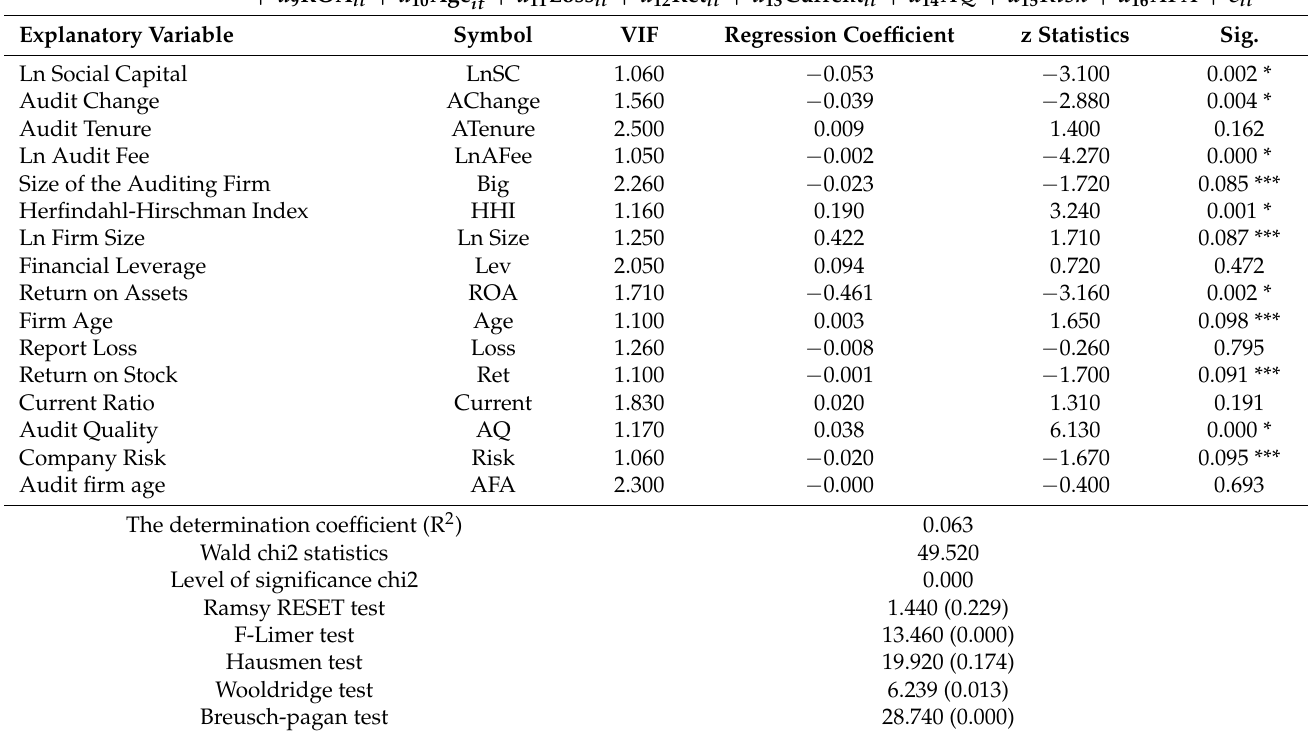
Table 8. The Results of testing the fourth